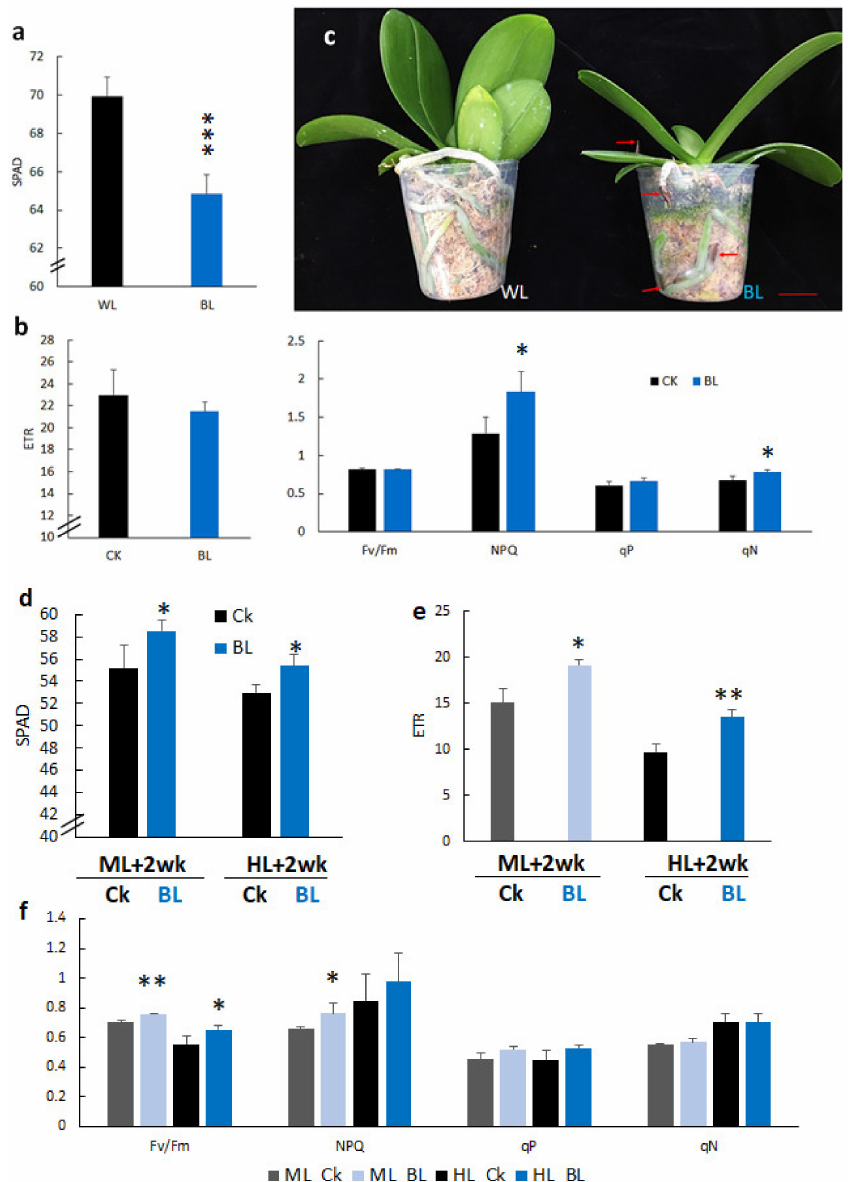
Figure 5. Blue light acclimation altered the growth and chlorophyll fluorescence parameters of orchid plants. ( a ) M1663 2.5” potted orchids treated with 100 µ mol m − 2 s − 1 blue light for 12 days (T0) altered the SPAD value. ( b ) BL acclimation a ff ected the chlorophyll fluorescence parameters. ( c ) The phenotype of orchid plants without or with BL acclimation for 12 days. Red arrows indicate the accumulation of anthocyanin in the orchid root tip. ( d – f ) E ff ect of BL acclimation-altered chlorophyll fluorescence of orchid plants after two weeks of exposure to moderate high (ML) and high light (HL) conditions. ( d ) SPAD value of orchid plants after two weeks of exposure to ML and HL. ( e ) ETR of orchid plants after being exposed to ML and HL for two weeks. ( f ) Chlorophyll fluorescence parameters of Fv / Fm, NPQ, qP and qN of orchid plants after being exposed to ML and HL for two weeks. ML, moderate light at 500 µ mol m 2 s − 1 . HL, high light at 1000 µ mol m 2 s − 1 . Abbreviations and statistical analyses